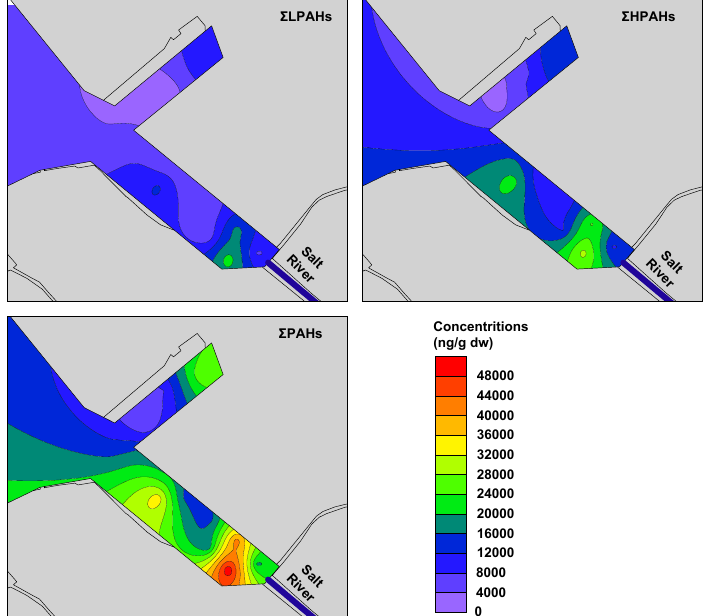
Figure 3. Distributions of Σ LPAH, Σ HPAH, and Σ PAHs in sediments from the industrial port area of southern Kaohsiung